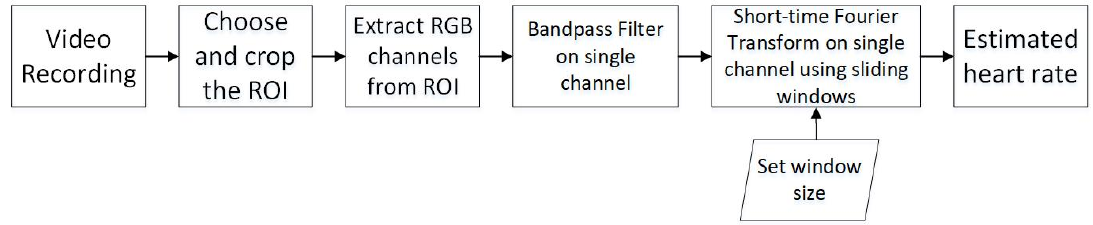
Figure 2. Flow chart representation of the different processing steps for heart rate extraction based on video data.